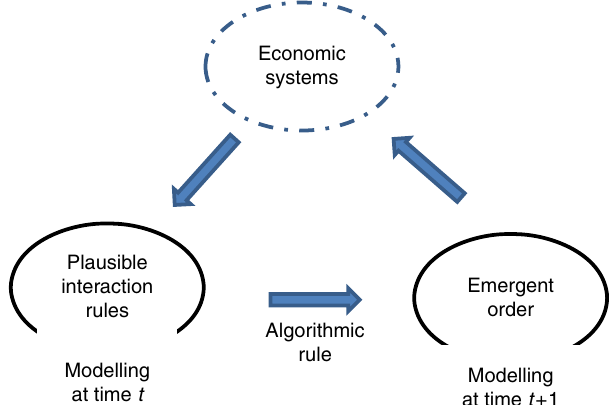
Figure 2. The adaptive